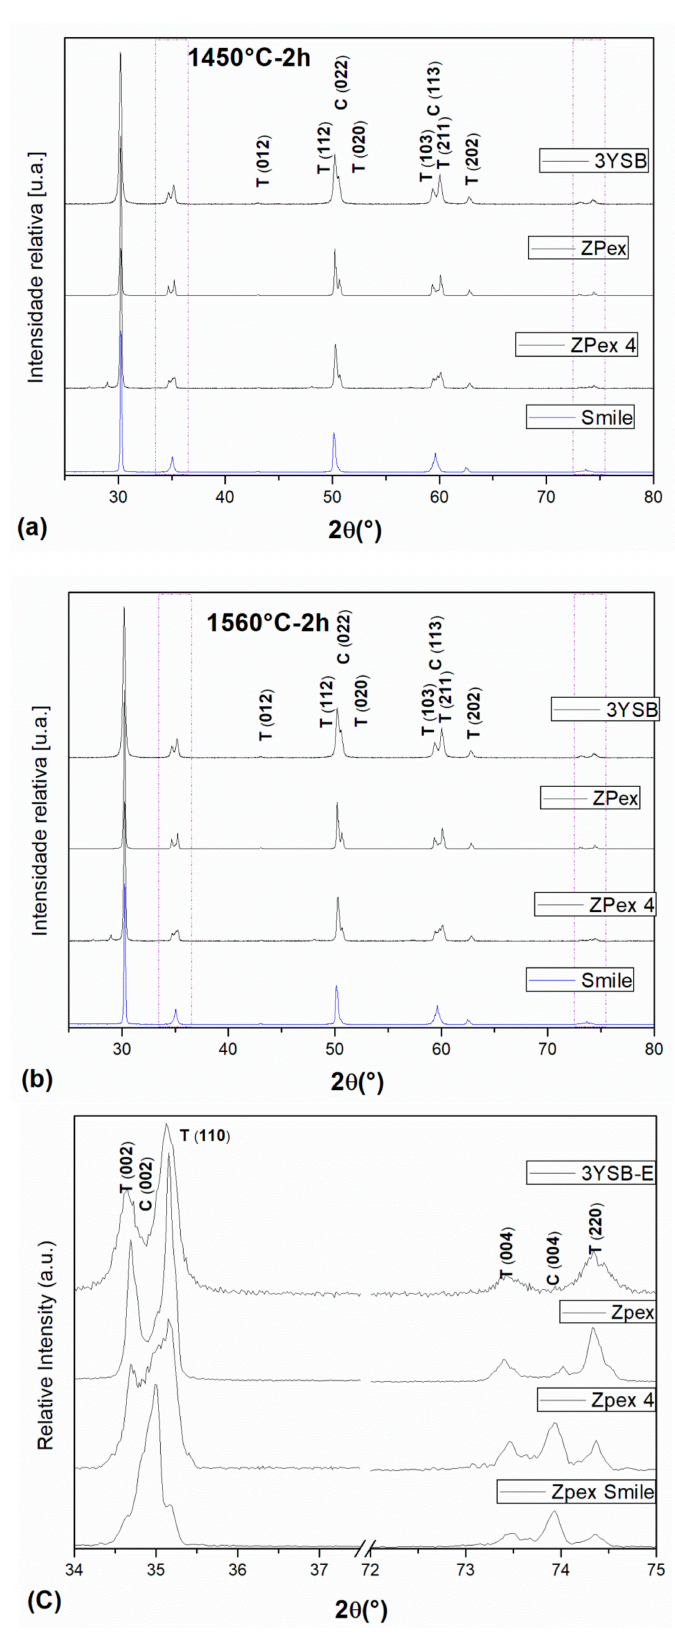
Figure 1. X-ray di ff raction patterns (XRD) of di ff erent zirconia ceramics for extreme sintering temperatures: ( a ) 1450 ◦ C, ( b ) 1560 ◦ C, and ( c ) detail of 2 theta between 34–37 ◦ and 45–70 ◦ , the region with the greatest variation of ZrO 2 -cubic and ZrO 2 -tetragonal